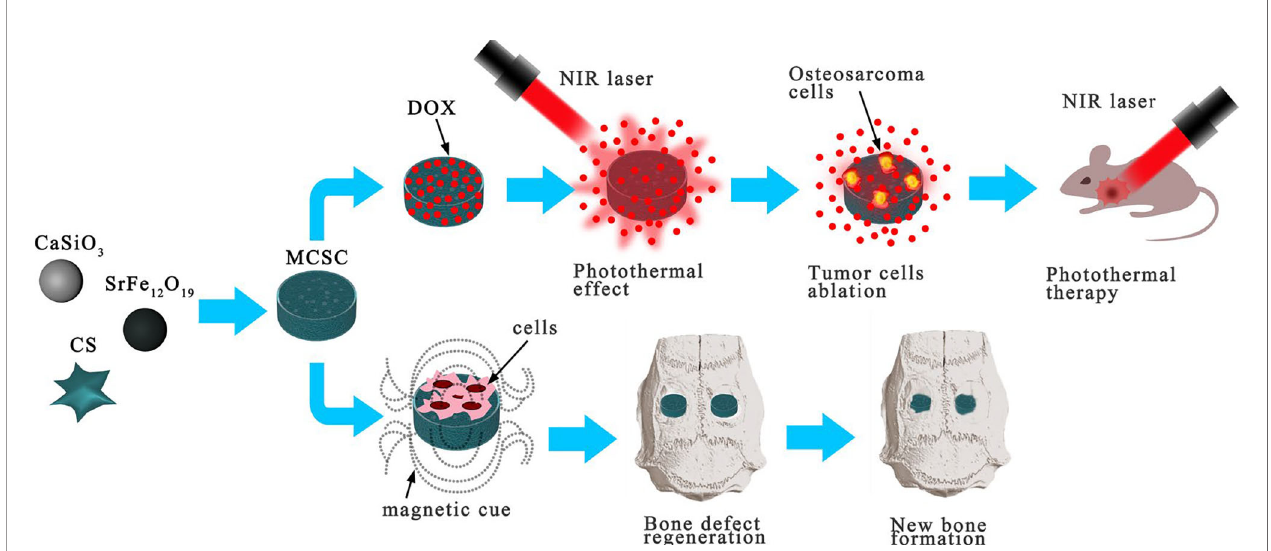
FIGURE 4 | MCSC scaffolds were composed of M-type ferrite particles and mesoporous calcium silicate microspheres dispersed in chitosan membrane. The scaffolds showed good drug delivery performance under NIR laser irradiation, and the MCSC scaffolds also had excellent ability to promote new bone regeneration. Reproduced from (15) with permission from Sci